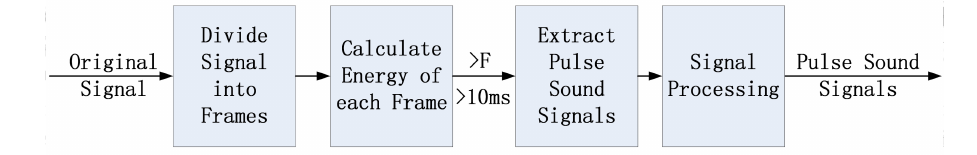
Figure 3. The Pre-Processing of Original